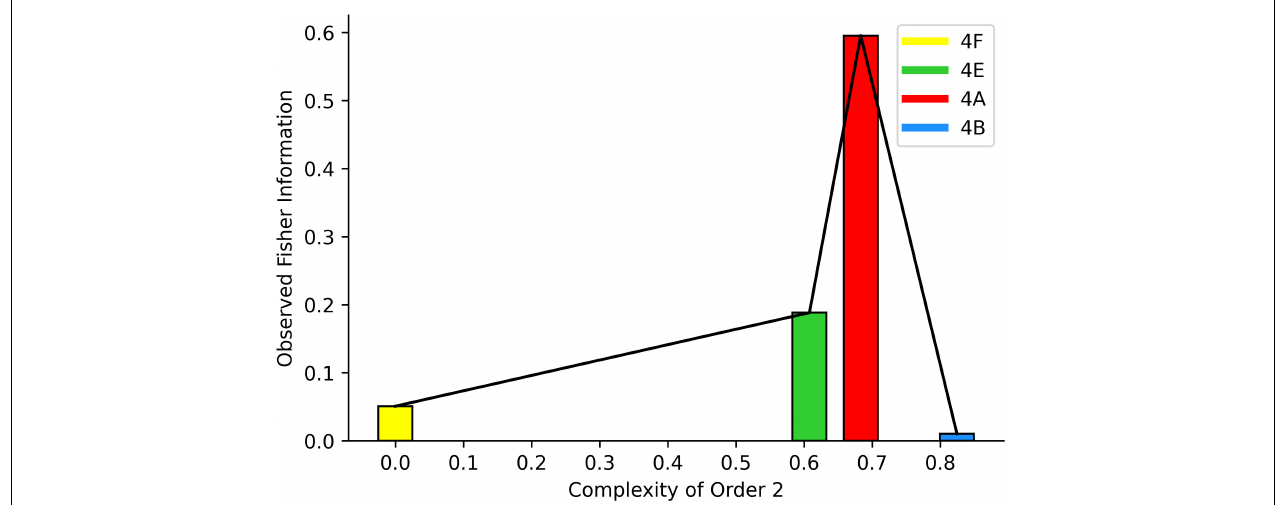
FIGURE 7 | Observed Fisher information as a function of complexity of order 2 for visual images in Figure 4 . The complexities of order 2 in the horizontal axis are from four panels of that figure as indicated by the legend. The likelihood function for the Fisher Information in the vertical axis was that of Equation 9, where P L was Gaussian with standard deviation 1. The value function input to the likelihood function was that of Equation 8. For that equation, we used w 1 as the free parameter. In turn, w 2 = 0 . 69 and w 3 = 0 . 09 were constants of the equation as determined by fit around the main peak in Figure 6B . Finally, we considered Equation 8 for the fully motivated system, that is, m ( t ) = 1. The results based on these equations reveal that the original figure (red) yields the optimal Fisher Information, with it falling when the Complexity of Order 2 is too low or too